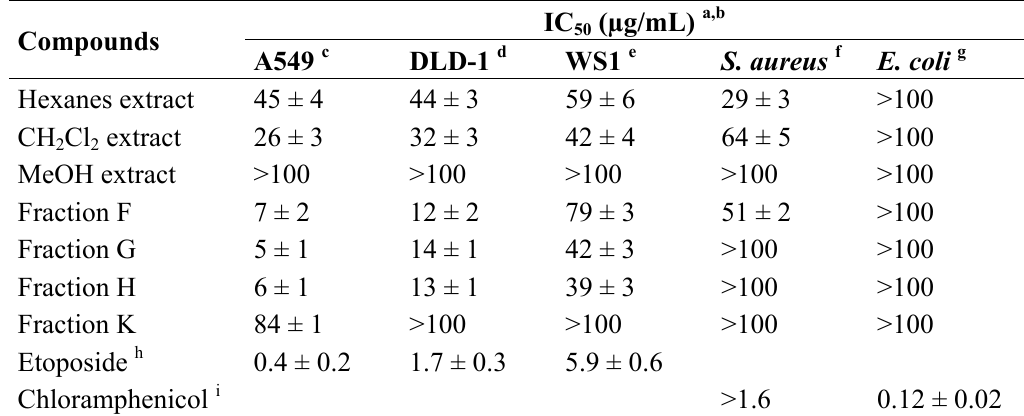
Table 1. Cytotoxic and antibacterial activities of extracts and